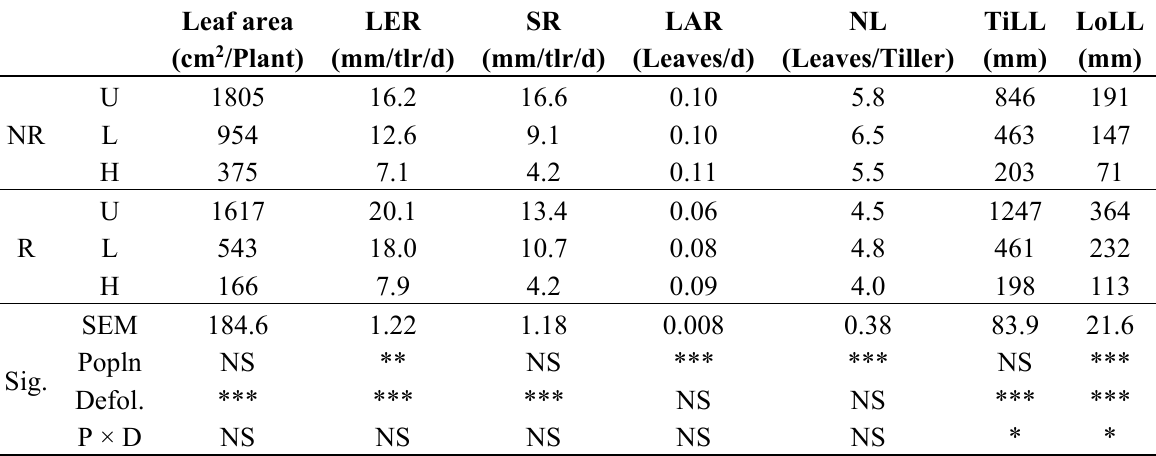
Table 4. Effect of defoliation regime and population on leaf area, leaf elongation rate (LER) per tiller per day, leaf senescence per tiller per day (SR), leaf appearance rate (LAR), number of live leaves per tiller (NL), tiller total leaf length (TiLL), and the longest live leaf per tiller (LoLL) for the final six weeks of observations. Data are for non-rhizomatous (NR) or rhizomatous (R) populations undefoliated (U) or under lax (L) or hard (H)